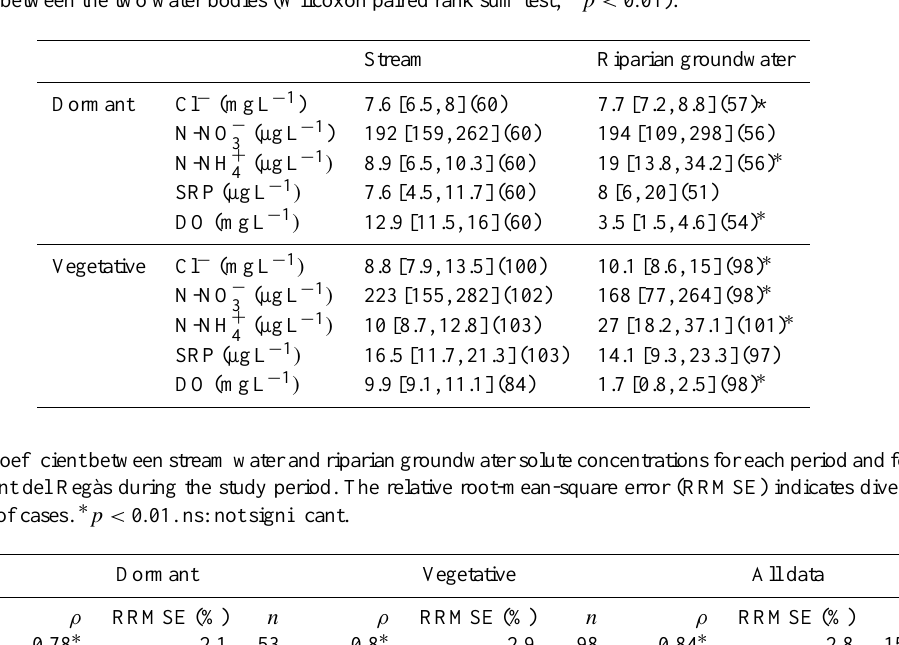
Table 1. Median and interquartile range [25th, 75th percentiles] of stream and riparian groundwater solute concentrations for the dormant and vegetative period. The number of cases is shown in parentheses for each group. For each variable, the asterisk indicates statistically significant differences between the two water bodies (Wilcoxon paired rank sum test, ∗ p < 0 . 01).